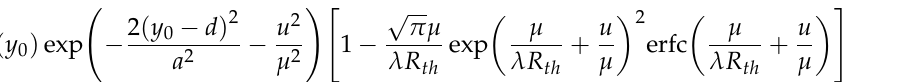
where 𝑇 (cid:3010) is the interference term of the crack on the temperature distribution, 𝑎 is the where T I is the interference term of the crack on the temperature distribution, a is the radius √ radius of the laser spot (at 1/ 𝑒 (cid:2870) of the intensity), 𝜇 (cid:3404) √ 4 𝑘𝑡 is the thermal diffusion of the laser spot (at 1/ e 2 of the intensity), µ = 4 kt is the thermal diffusion length, and √ length, and 𝜀 (cid:3404) 𝜆 / √𝑘 is the thermal effusivity. Air is the main filling medium inside the k is the thermal effusivity. Air is the main filling medium inside the crack; its ε = λ / crack; its thermal conductivity is 𝜆 (cid:3028)(cid:3036)(cid:3045) , and the width of the crack contained in the model thermal conductivity is λ air , and the width of the crack contained in the model is L , so is 𝐿 , so the thermal resistance coefficient of the crack is expressed as 𝑅 (cid:3047)(cid:3035) (cid:3404) 𝐿 / 𝜆 (cid:3028)(cid:3036)(cid:3045) . 𝑅 (cid:3047)(cid:3035) the thermal resistance coefficient of the crack is expressed as R th = L / λ air . R th reflects reflects the resisting effect of the crack, and with the increase in 𝑅 (cid:3047)(cid:3035) , the blocking effect on the resisting effect of the crack, and with the increase in R th , the blocking effect on heat heat conduction becomes more significant. 𝜂 is the heat absorption energy fraction of the conduction becomes more significant. η is the heat absorption energy fraction of the model, model, which denotes the energy absorption efficiency. Then, 𝑢 (cid:3404) | 𝑦 | (cid:3397) | 𝑦 (cid:2868) | , where 𝑦 (cid:2868) is which denotes the energy absorption efficiency. Then, u = | y | + | y 0 | , where y 0 is the y -axis the y ‐ axis coordinate of the laser spot center [22]. coordinate of the laser spot center [22].